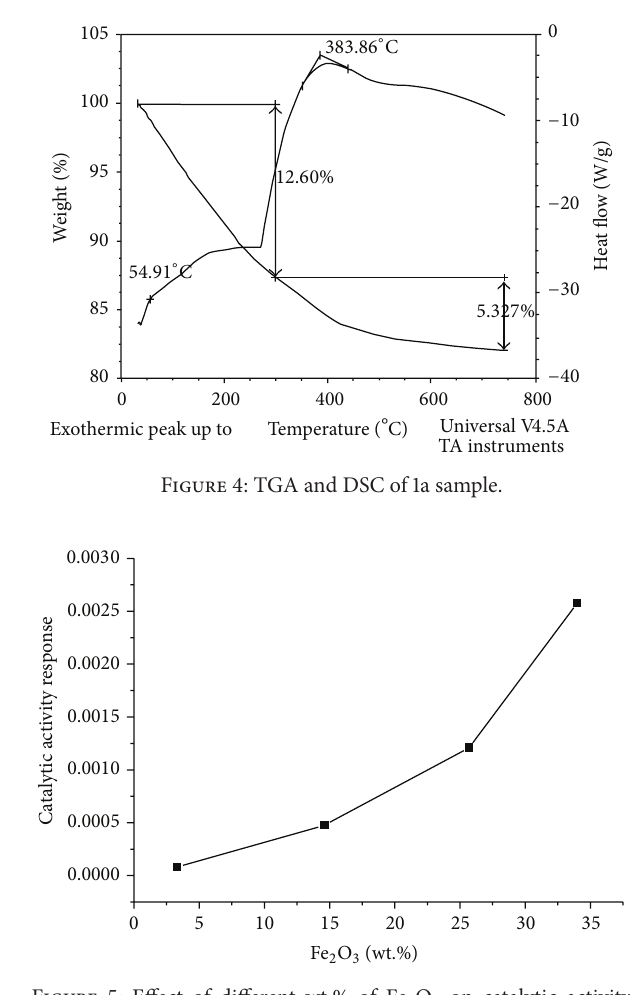
Figure 5: Effect of different wt.% of Fe 2 O 3 on catalytic activity response in series